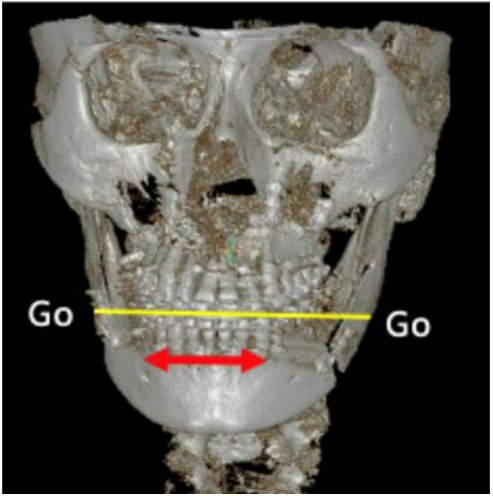
Figure 2. Mandibular intergonial width: Go–Go.